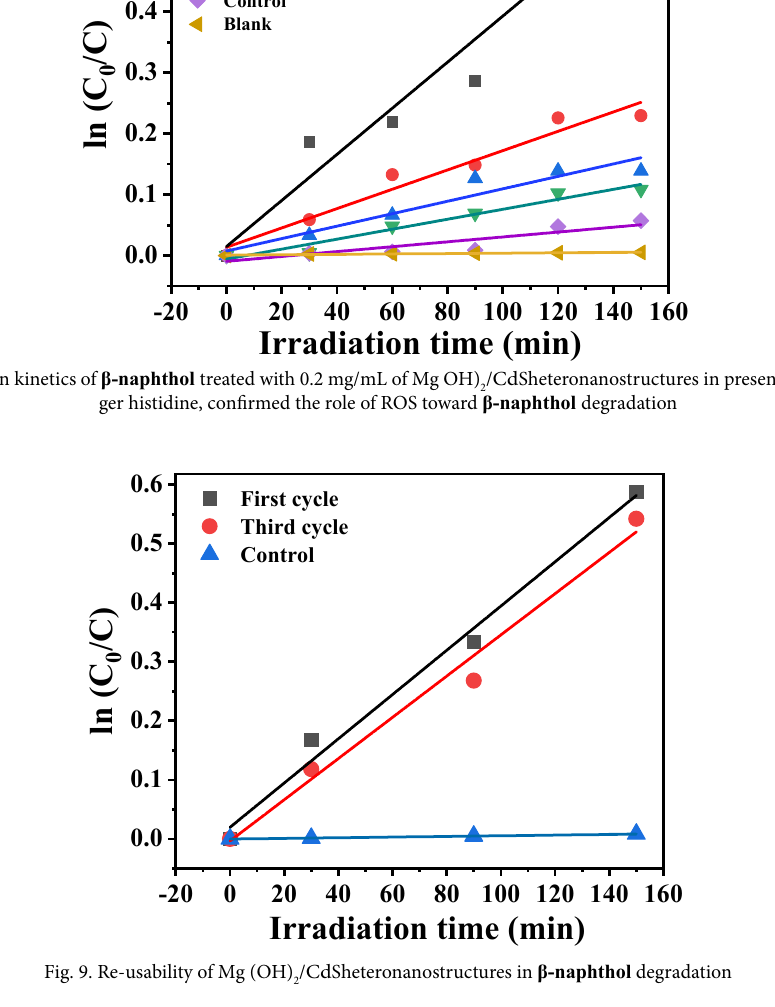
/CdSheteronanostructures in β-naphthol 2